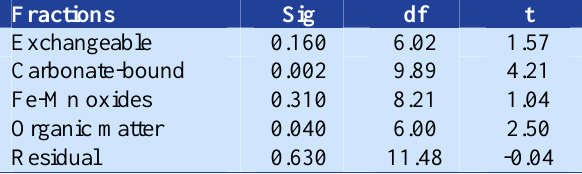
Table 5. Statistical test results for Cu in each fraction between the contaminated soil with Actinidia deliciosa and the control